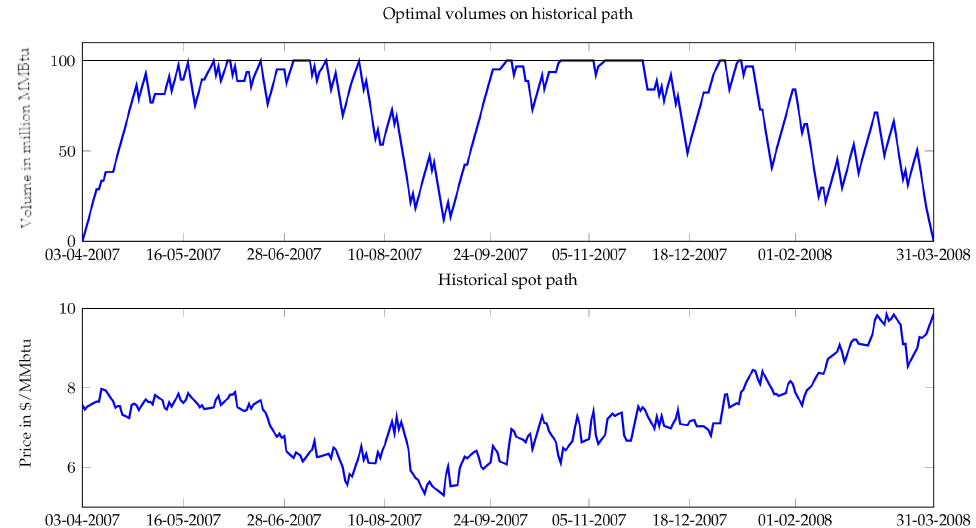
Figure 6. Historical spot path and optimal volumes (fast storage). bottom panel: historical path, top panel: the optimal storage level on the historical path.